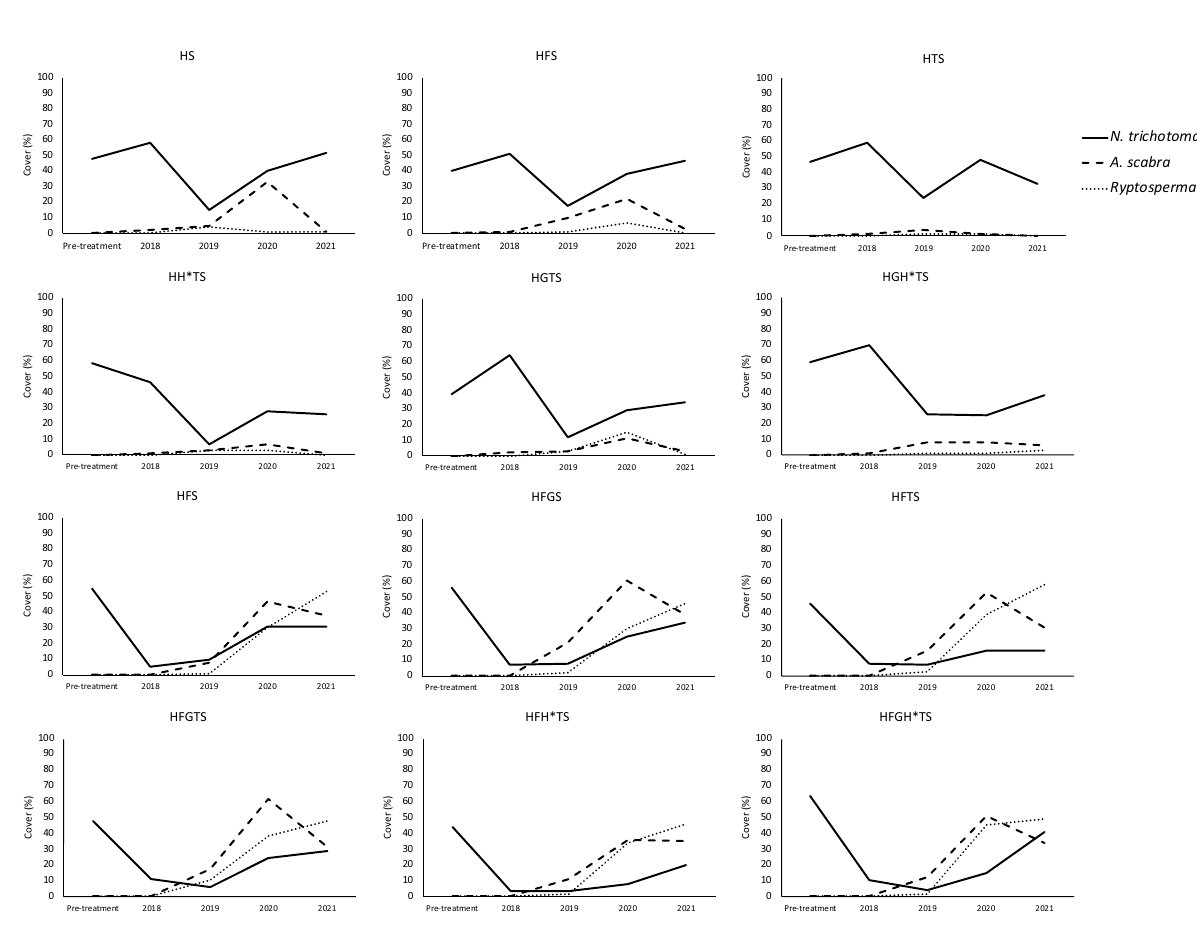
Figure 2. The mean cover (%) of N. trichotoma (solid line) and the two-broadcast species: A. scabra (dashed line) and Rytidosperma spp. (dotted line) for each treatment over the five sampling